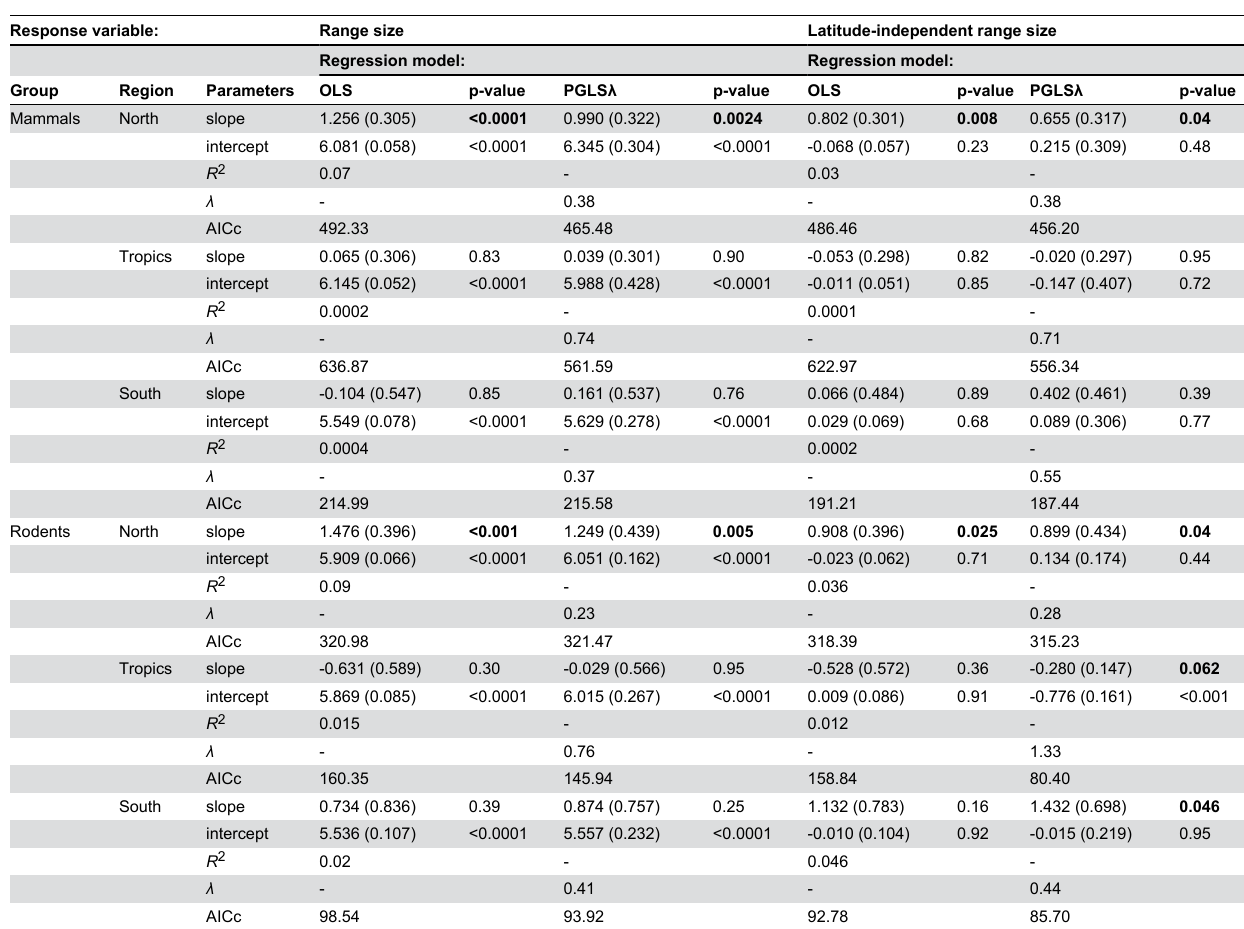
Table 3. Regional non-phylogenetic (OLS) and phylogenetic (PGLSλ) simple linear regressions of geographic range size as a function of MIBMR in all mammals and rodents in the North (> 23.7° lat), Tropics (23.7° to -23.7° lat), and South (< -23.7°